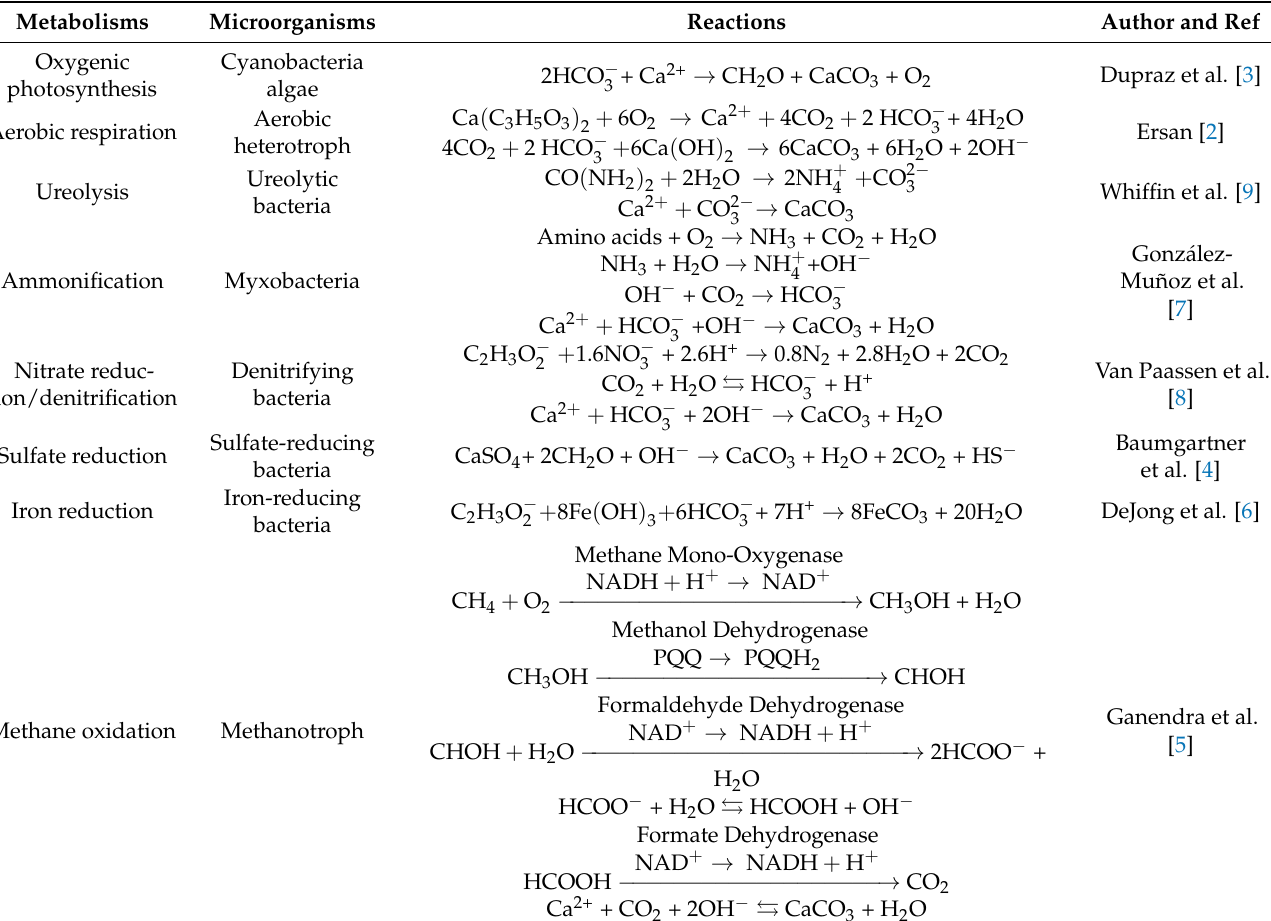
Table 1. Reactions involved in different metabolic pathways leading to